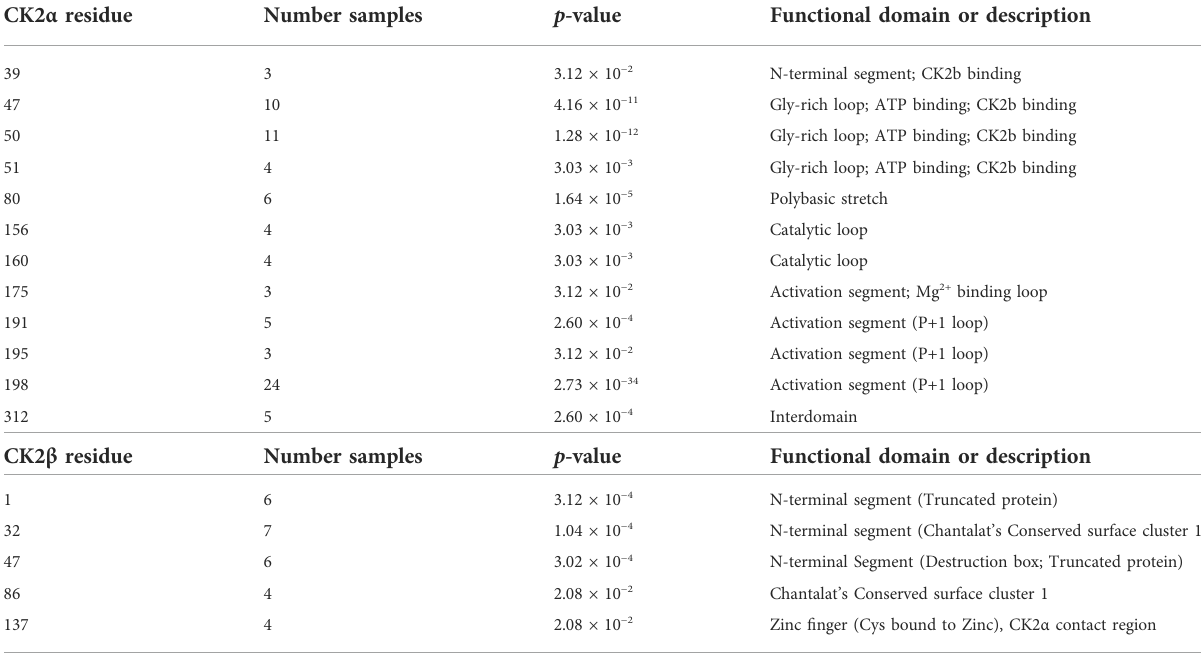
TABLE 3 Nonrandom mutation clustering (NMC) for CK2 α and CK2 β mutations. Analysis was performed on the total number of patients with mutations in each amino acid residue (excluding splice site mutations). Table only includes signi fi cant clusters with a cluster size of one amino acid